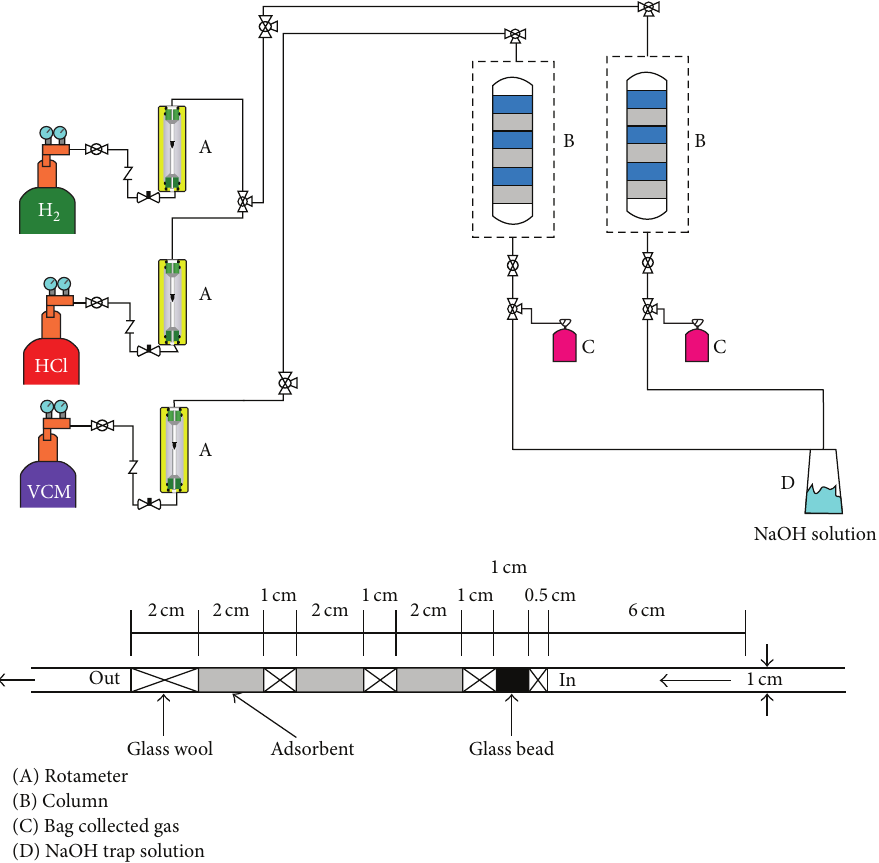
Figure 1: Fixed-bed flow column.